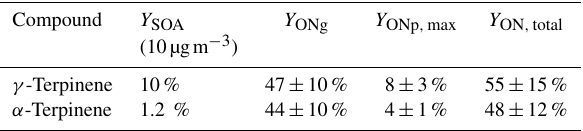
Table 5. Mean SOA and organic nitrate yields obtained in this study for γ -terpinene and α